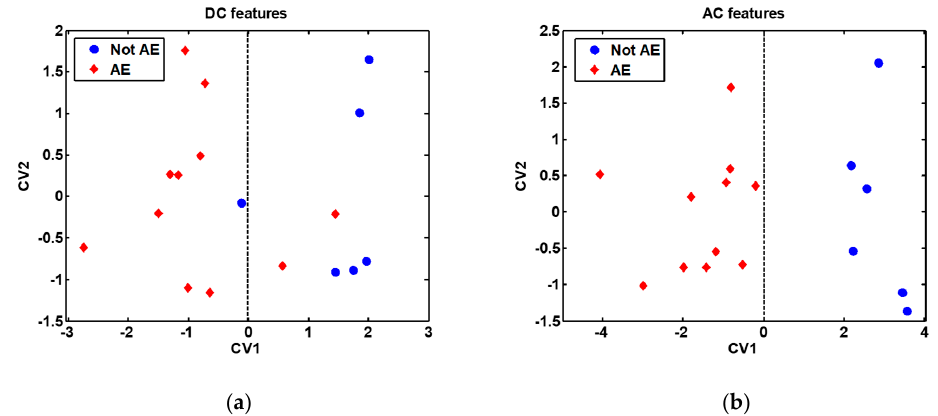
Figure 7. Discriminant Function Analysis (DFA) models built with all samples (without bootstrap validation), shown for visualization purpose only: ( a ) DFA model built with features extracted from the DC measurements; ( b ) DFA model built with features extracted from the AC measurements. The features used to build the DFA models are indicated in Table 2. AE: Alveolar echinococcosis; Not AE: Control. CV1: First (and most discriminative) canonical variable of the DFA model; CV2: Second canonical variable of the DFA model. The decision border is given by the vertical dashed line passing through the zero value on the CV1 axis.